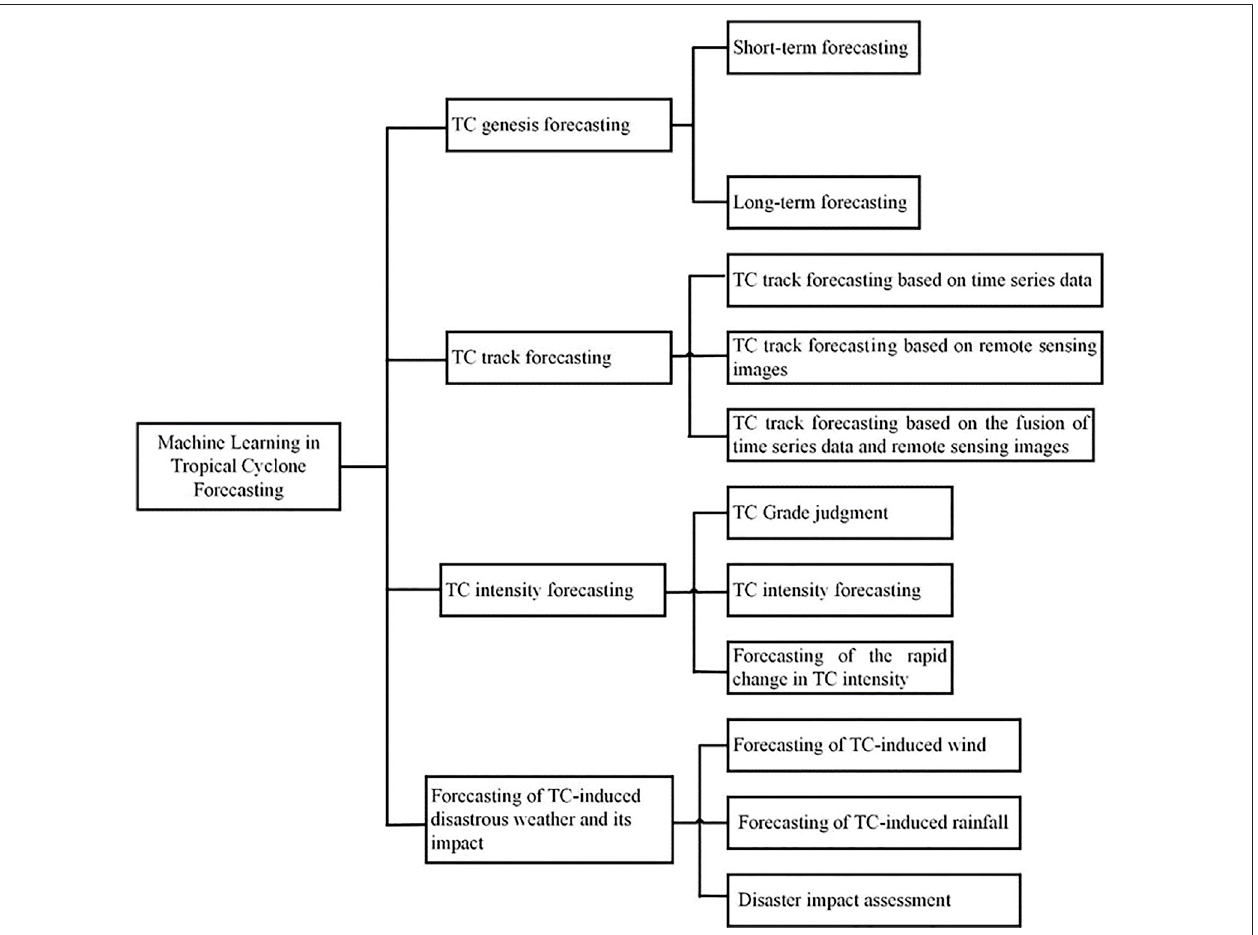
FIGURE 1 | Overview of the application of machine learning methods in TC